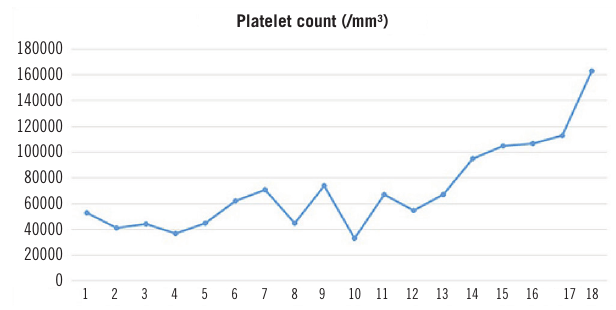
figurE 4 − Variation of platelet count during hospital stay